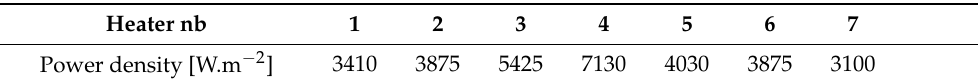
Table 6. Power densities for anti-icing Case 87b